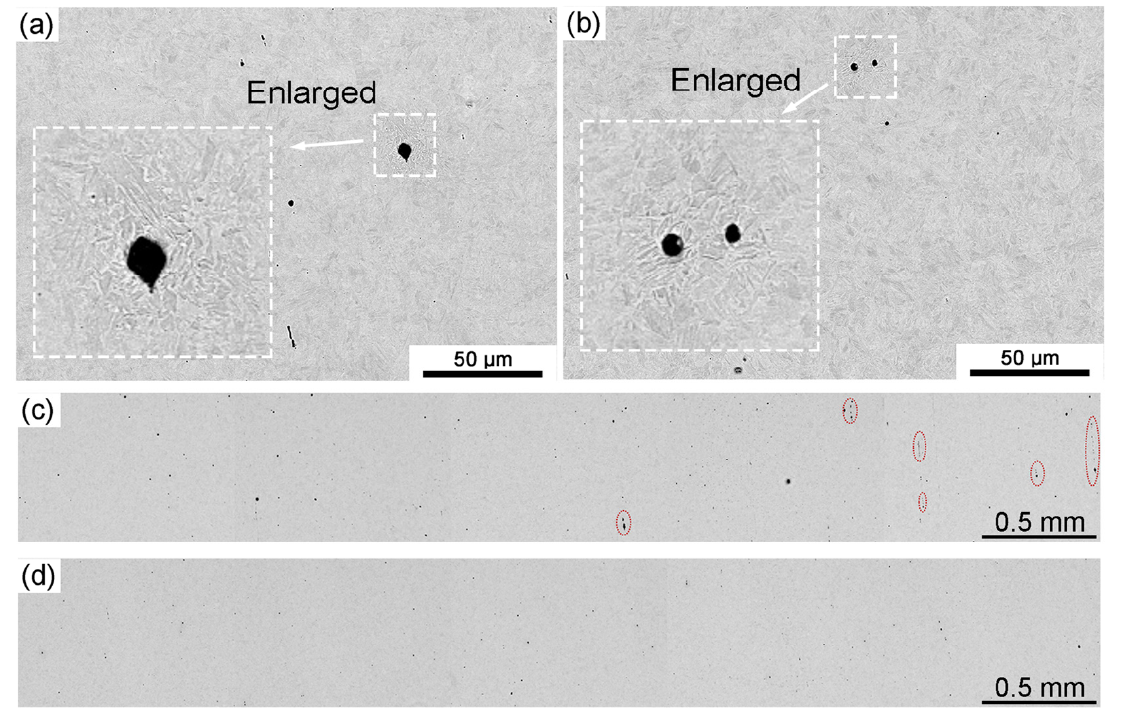
Figure 8. Matrix corrosion aggravated by the inclusions for the samples after quenching of ( a ) tra- ditional process ( b ) CSP process, and the distribution of inclusions over a macro fi eld of view for ( c ) traditional process ( d ) CSP process.